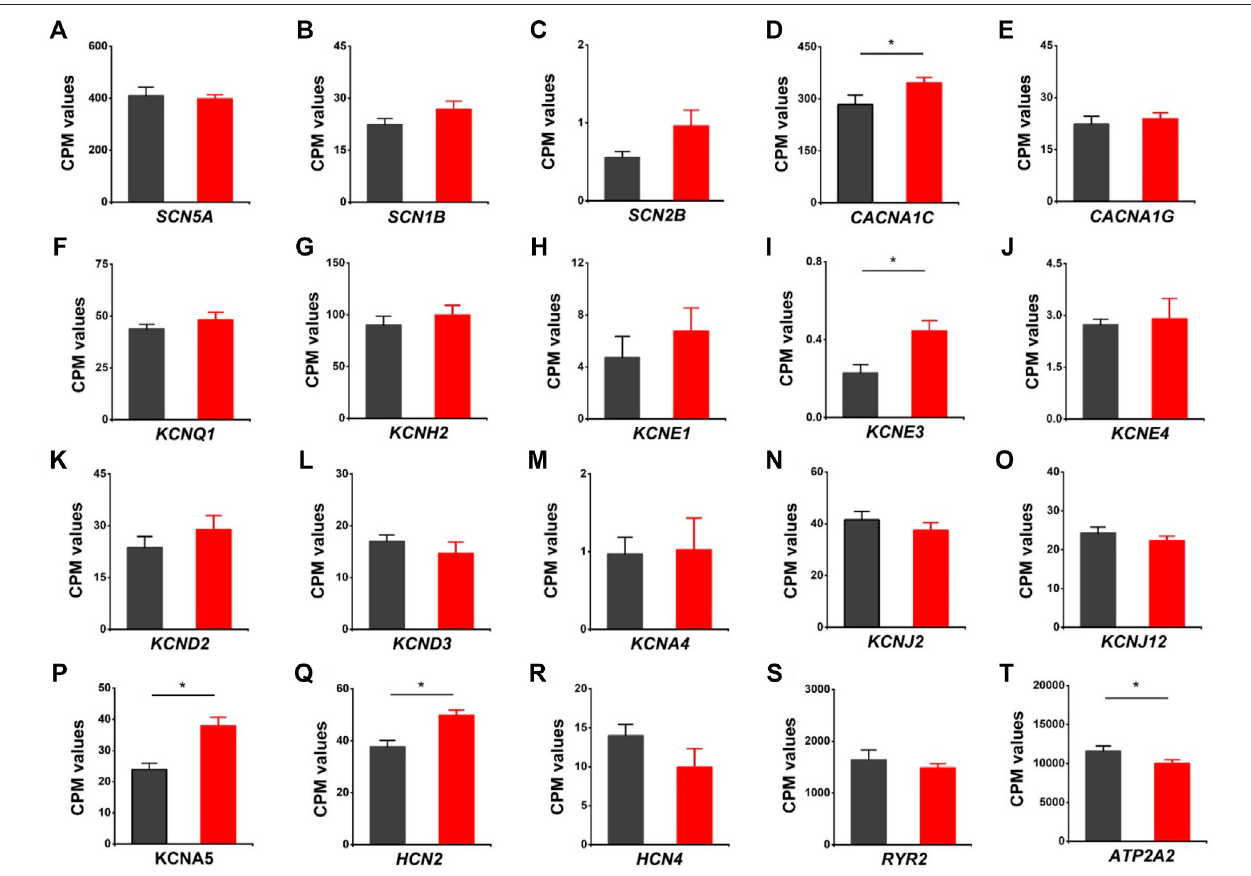
FIGURE 6 | Differentially expressed genes related to cardiac ion channels in HVCN1 − / − hearts. Comparing relative gene expression levels of cardiac ion channels betweenWT(black)andHVCN1 − / − (red)includingcardiacsodiumchannel SCN5A (A) ,sodiumchannelbetasubunits SCN1B and SCN2B (B-C), cardiacL-typecalcium channel CACNA1C (D) ,T-typecalciumchannel CACNA1G (E) ,cardiacpotassiumchannels KCNQ1 (F) , KCNH2 (G) ,potassiumchannelbetasubunits KCNE1 , KCNE3 , KCNE4 (H-J), I to channels KNCD2 , KCND3 , KCNA4 (K-M) , I K1 channels KCNJ2 , KCNJ12 (N-O) , I kur channel KCNA5 (P) , I f channels HCN2 , HCN4 (Q-R) , and cardiac ryanodine receptor RYR2 (S) and SERCA pump ATPA2 (T) . n = 4 independent experiments for RNA-seq; * p < 0.05.